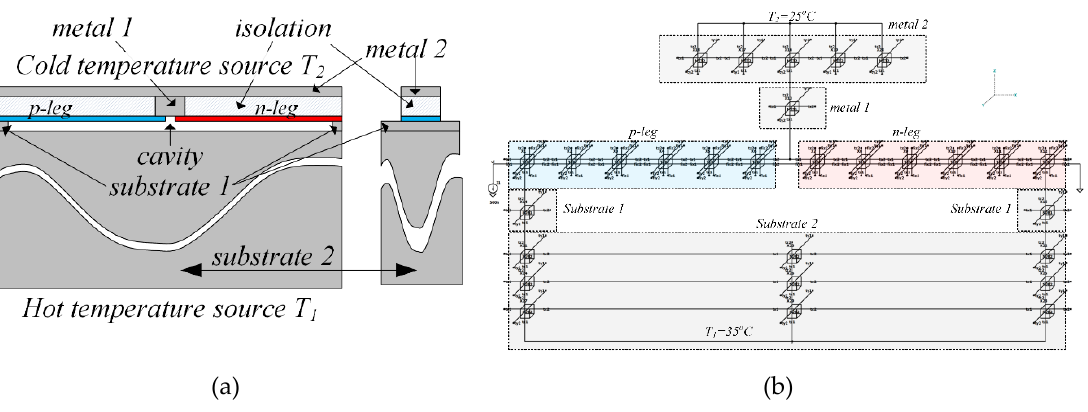
Figure 11. The planar on-chip thermoelectric couple: ( a ) schematic front and side views and ( b ) simulation scheme, built from hierarchical blocks shown in Figure 6 and Figure 7 for different materials.